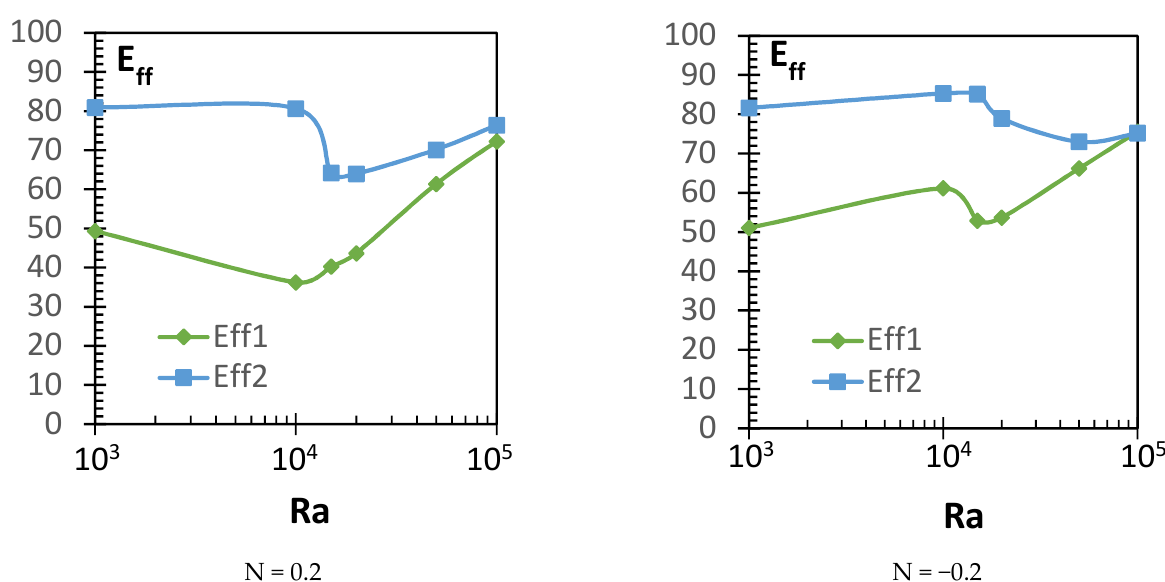
N = 0.2 N = −0.2 Figure 15. Effect of the Rayleigh number on the efficiency of the barrier for N = 0.2 and N = −0.2; Eff1 and Eff2 are the barrier efficiencies for H 1 = 0.25 and H 2 = 0.5, respectively.